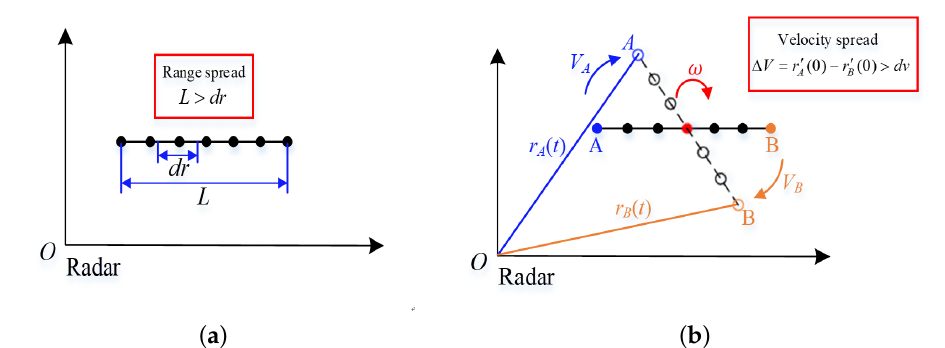
Figure 5. The difference between the phenomenon of range spread and motion spread. ( a ) The phenomenon of range spread; ( b ) The phenomenon of motion